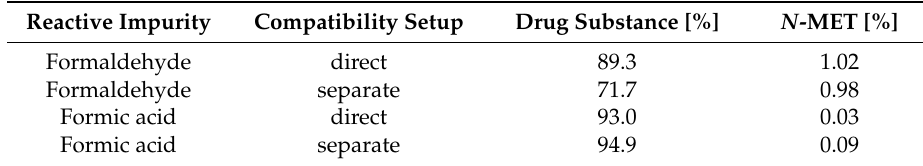
Table 4. N -methyl impurity formation with a direct reactive impurity spike. Paroxetine hydrochloride (50 mg) was weighed into glass vials to which 10 µ L of stressing liquid was added. The exact molar ratios are 1:0.985 (formaldehyde) and 1:1.94 (formic acid). The N -methyl paroxetine ( N -MET) and drug substance [%] presents area % of the concerning peak after seven days at 60 ◦ C in closed vials. Reactive Impurity